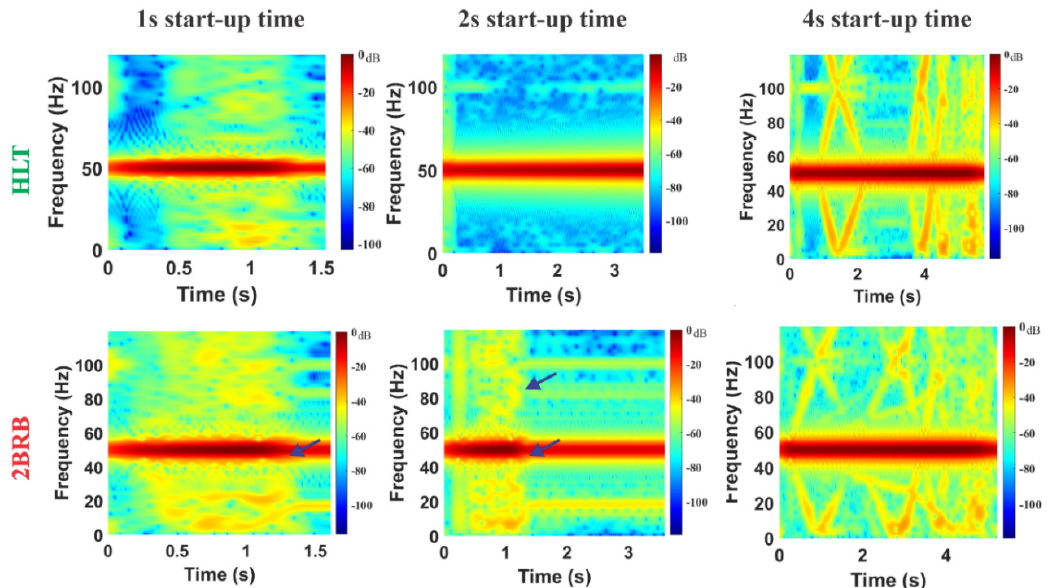
Figure 11. STFT t-f maps obtained by analyzing the current signal of the IM for different start-up time transients when using Schneider soft-starter for healthy motor, and one with two broken rotor bars.